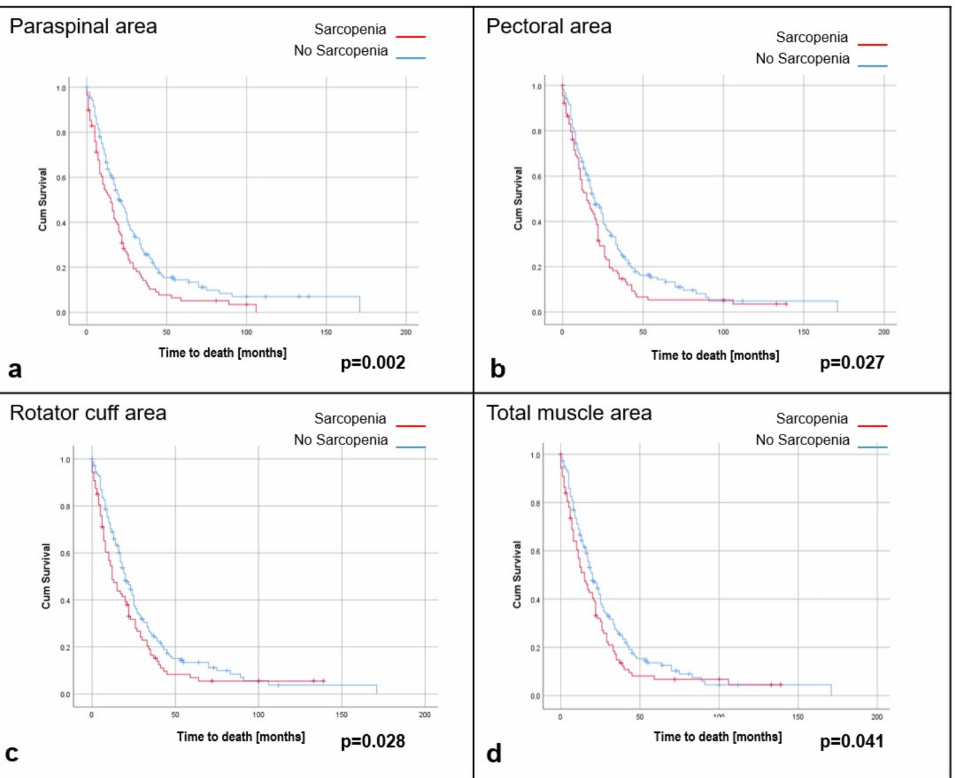
Figure 4. Kaplan-Meier statistics for surgically treated PM-patients with or without sarcopenia, defined as the sex-related 33rd percentile of the ( a ) paraspinal area, ( b ) pectoral area, ( c ) rotator cuff area, and ( d ) total muscle area at the 5th thoracic vertebra.